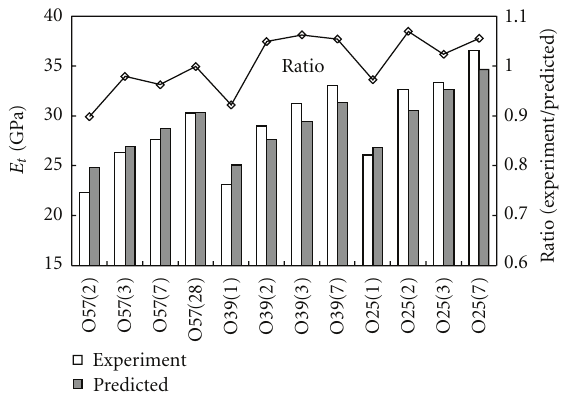
Figure 12: Comparison of experiment and predicted tensile Young’s modulus.